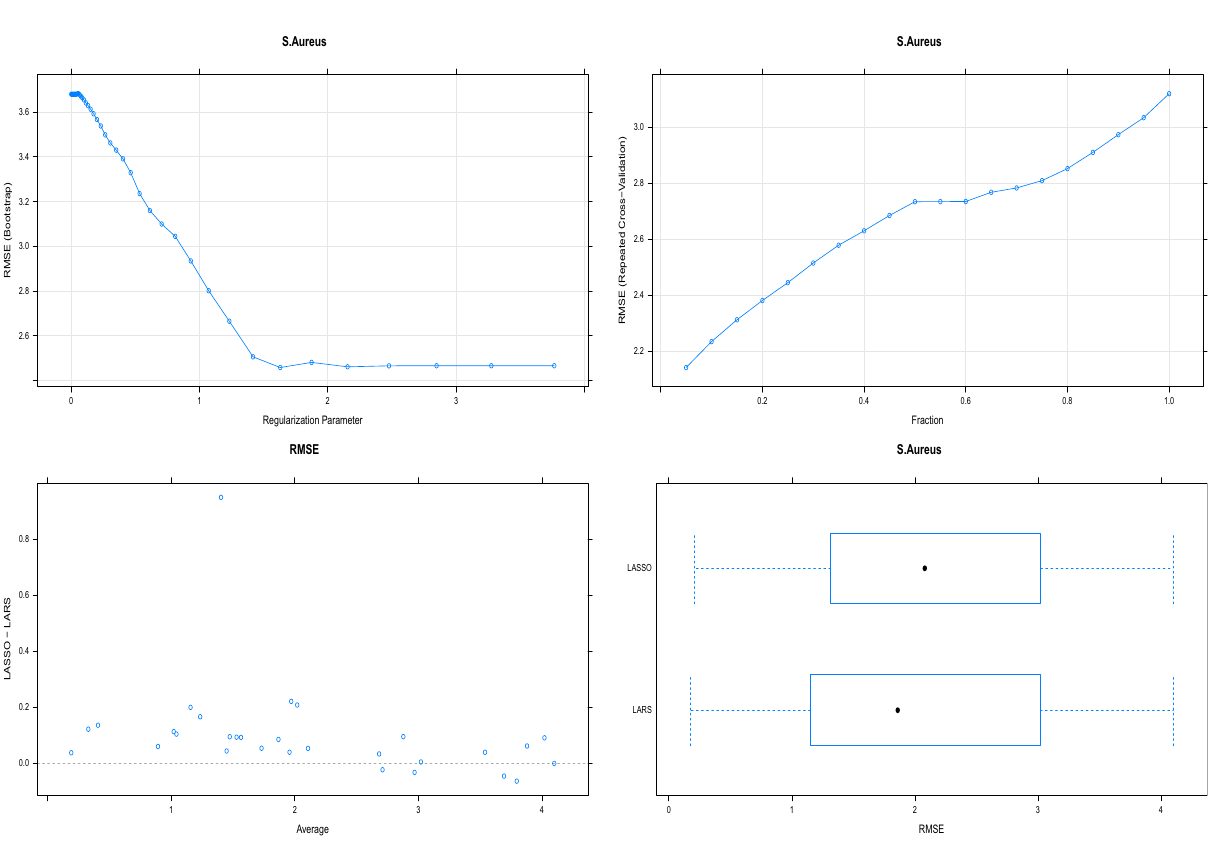
Figure 3. RMSE is used to assess the ability of a model to predict MTZ antibacterial activity against S. aureus . In the upper left and right panels, the RMSE behaviour of LASSO and LAR against their regularized parameter (theta) and fraction. We used bootstrap cross validation for model fitting, comparing the model RMSE in each